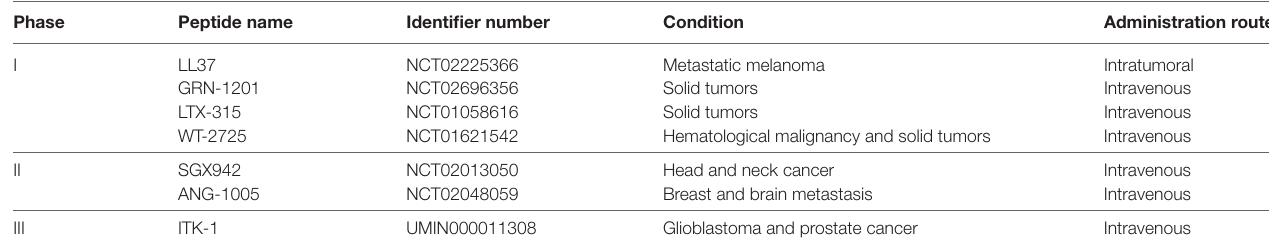
TABLe 1 | Antimicrobial peptides for oncologic indications in ongoing clinical trials.